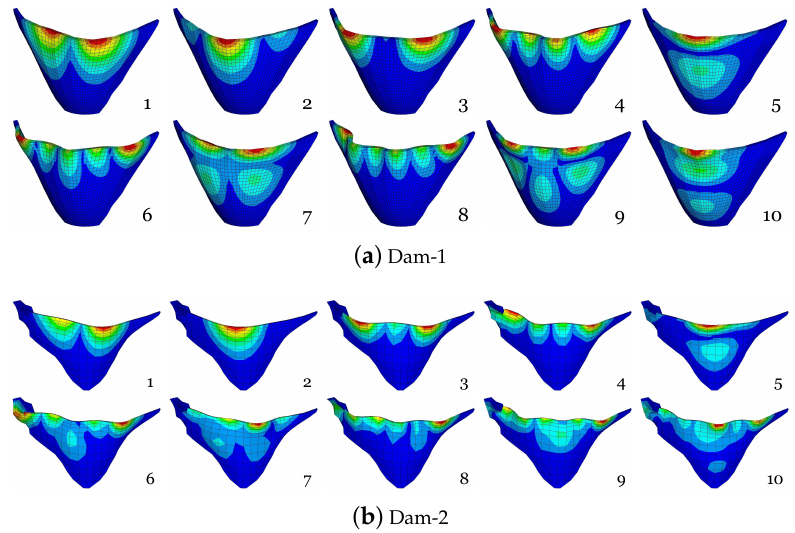
Figure A1. First ten mode shapes of the studied dams with homogeneous model.